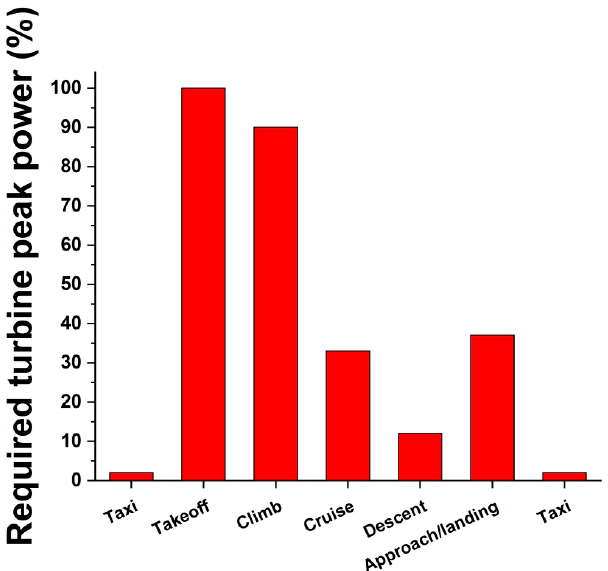
Figure 3. Typical required turbine peak power per mission segment for a representative flight of a 150-passenger single-aisle aircraft with 5600 km (3000 nautical miles) design range flying a 1900 km (1000 nautical miles) mission—adapted from [19].